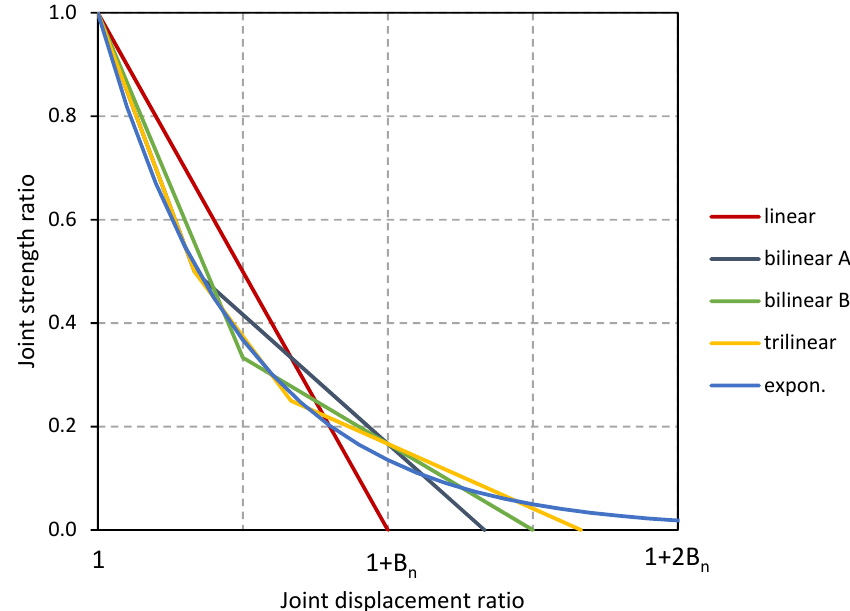
Figure 6. Approximation of exponential curve by 4 segmented curves with equal fracture energy. Table 1. Definition of the piecewise linear post-peak weakening curves in Figure 6.